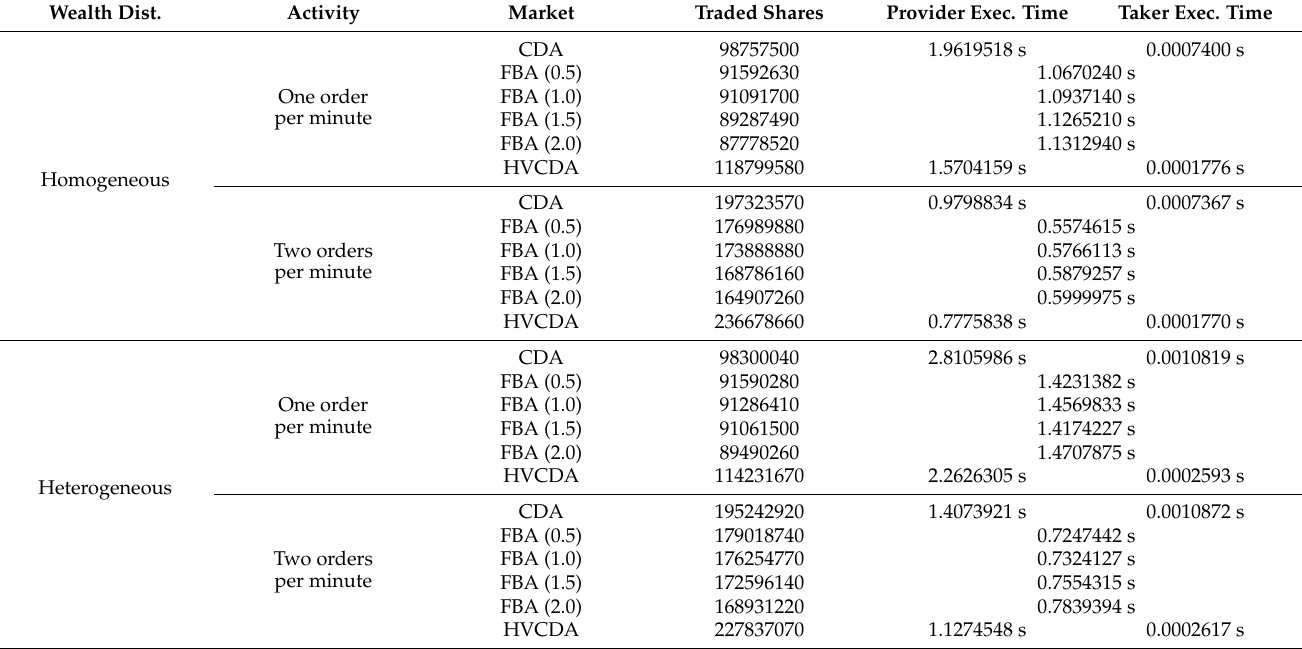
Table 6. Orders execution information. “Traded Shares” includes all shares that were executed during the trading day. “Provider” refers to the liquidity provider in the operation, and “Taker” refers to the liquidity taker in the operation. Since all orders are matched during the auction stage in FBA markets, there is no notion of liquidity provider or taker. All execution times averages are per